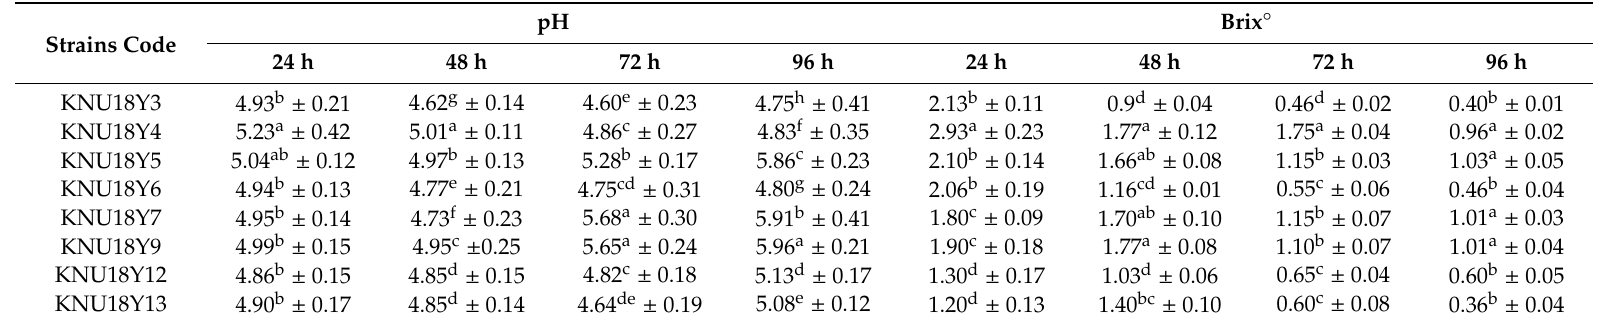
Table 6. The pH and Brix of fermented co ff ee pulp media by di ff erent yeast